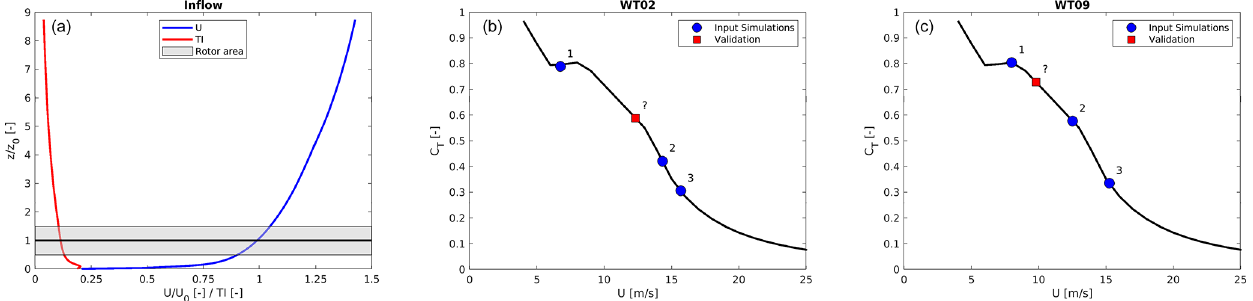
Figure 2. (a) Normalized and averaged streamwise velocity and turbulence intensity profiles; steady-state C T curve and C T values (b) for the wake-generating first turbine and (c) for the wake-generating eighth turbine in the input simulations and validation case in blue and red,